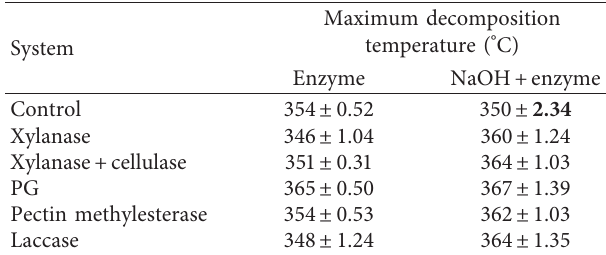
Figure 17: (a) Improved adhesion between PLA and the enzyme-retted fibre due to different surface morphologies of (b) untreated and (c) enzyme-retted fibres [158]. Table 9: Maximum decomposition temperature for different systems